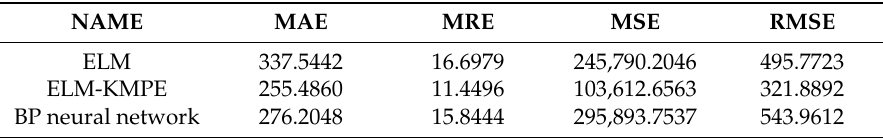
Table 1. Prediction error between ELM, ELM-KMPE, and BP neural